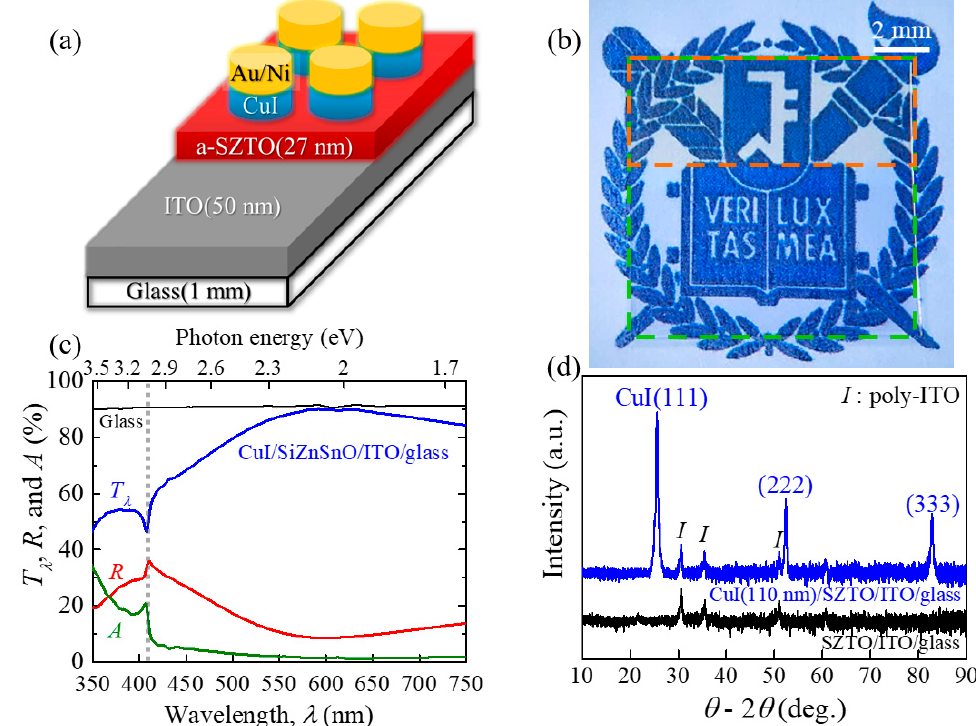
Figure 1. ( a ) A schematic structure of the p -CuI/ n -SiZnSnO (SZTO) diode grown on the ITO deposited glass substrate, which was used for electrical characterization in this work. The CuI film of circular disk shape (with a diameter of 50 μ m) were fabricated in two thicknesses of 140 and 20 nm while the thicknesses of SZTO and ITO films were 27 and 50 nm, respectively. Au/Ni ( t = 50/5 nm) films were subsequently deposited on top of the CuI disk. ( b ) A separate film fabricated for optical characterization. The CuI(110 nm)/SZTO(27 nm) (the orange dashed line) were homogeneously deposited on top of the ITO/glass substrate (the green dashed line). All the regions exhibit clearly optical transparency. ( c ) Optical transmittance ( T λ ), reflectance ( R ), and absorption ( A ) spectra of the CuI (110 nm)/SZTO/ITO/glass sample shown in ( b ). The black solid line represents T λ of a glass substrate ( t = 1 mm) only. ( d ) X-ray θ -2 θ scan results of the CuI (110 nm)/SZTO/ITO/glass film shown in ( b ) and of another SZTO/ITO/glass film. The CuI film exhibits the preferential orientation of a (111) plane, and additional peaks represent a polycrystalline ITO film indicated as I .